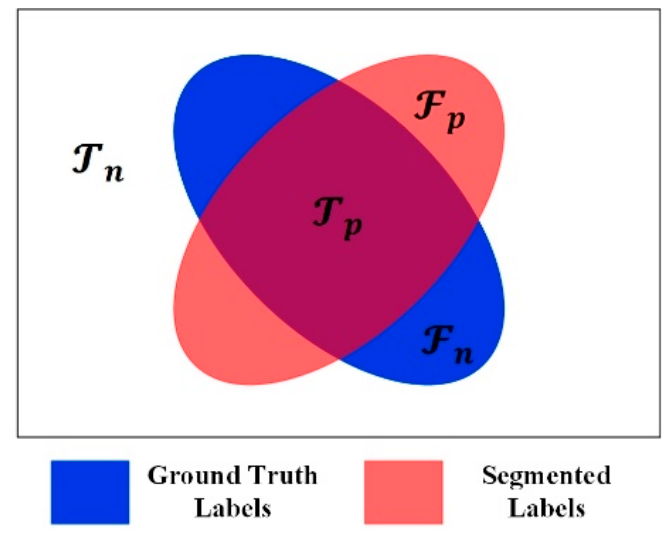
Figure 6. Illustration of predicted labels.